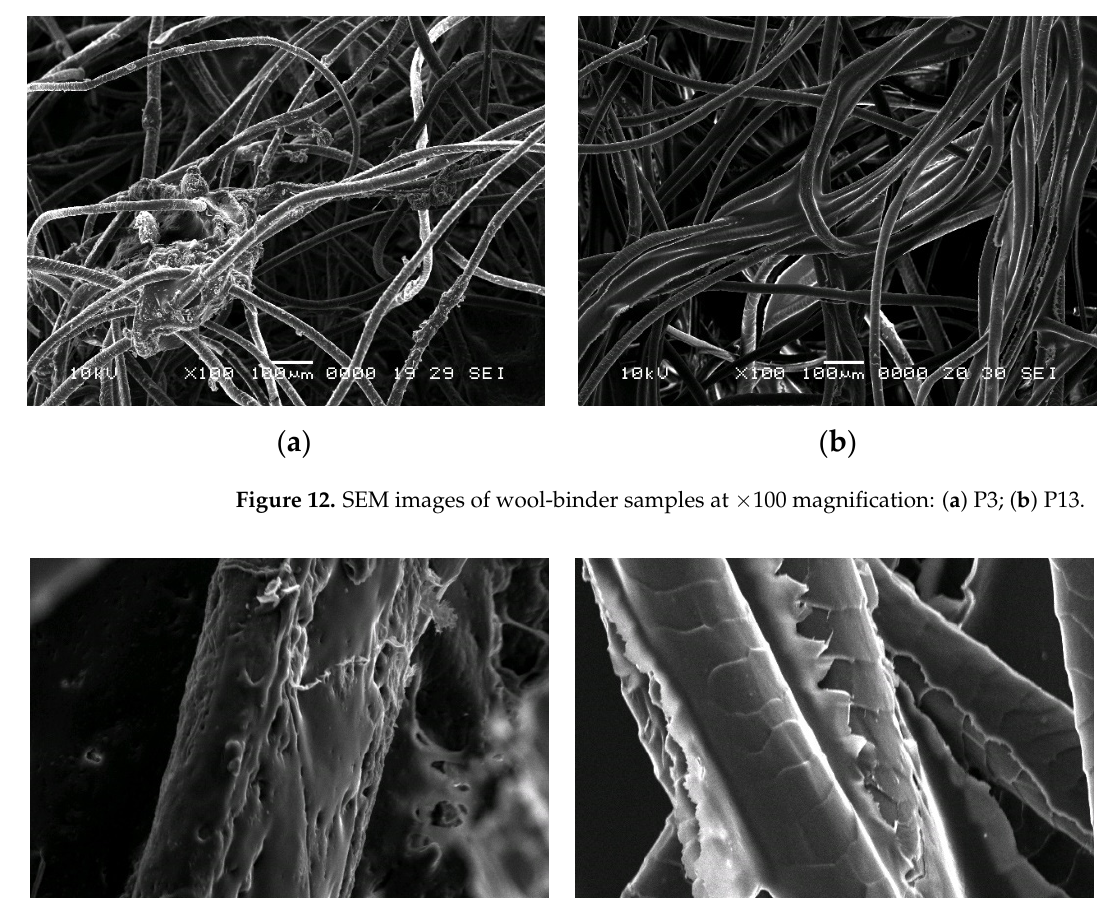
From the previous figures, the dispersion of the binder over the fibres can be seen,